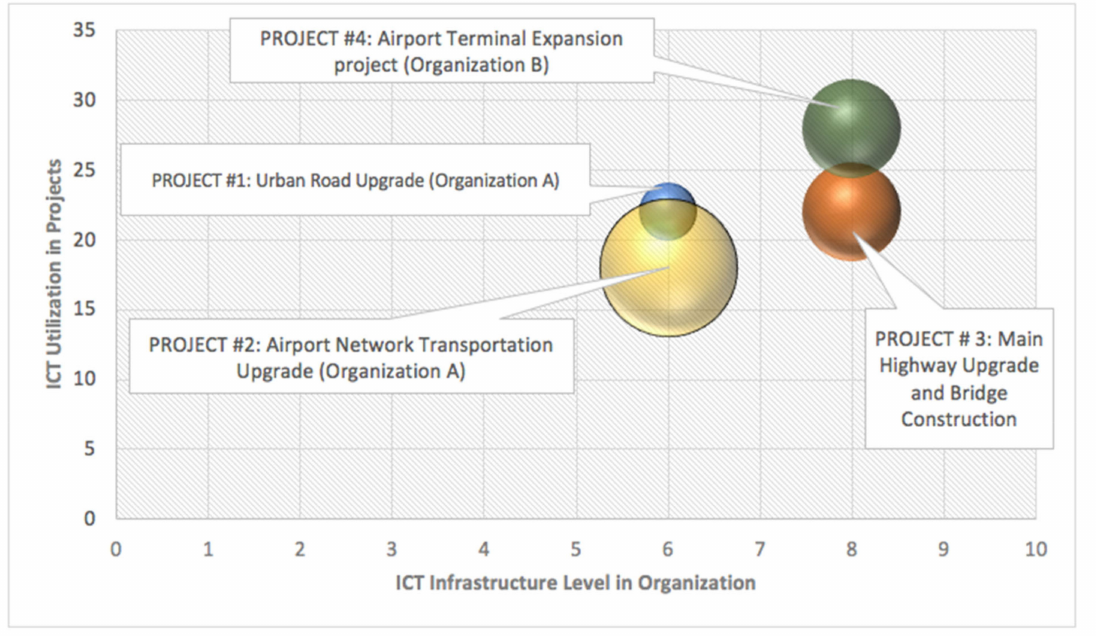
Figure 7. ICT infrastructure, ICT utilization, and project performance